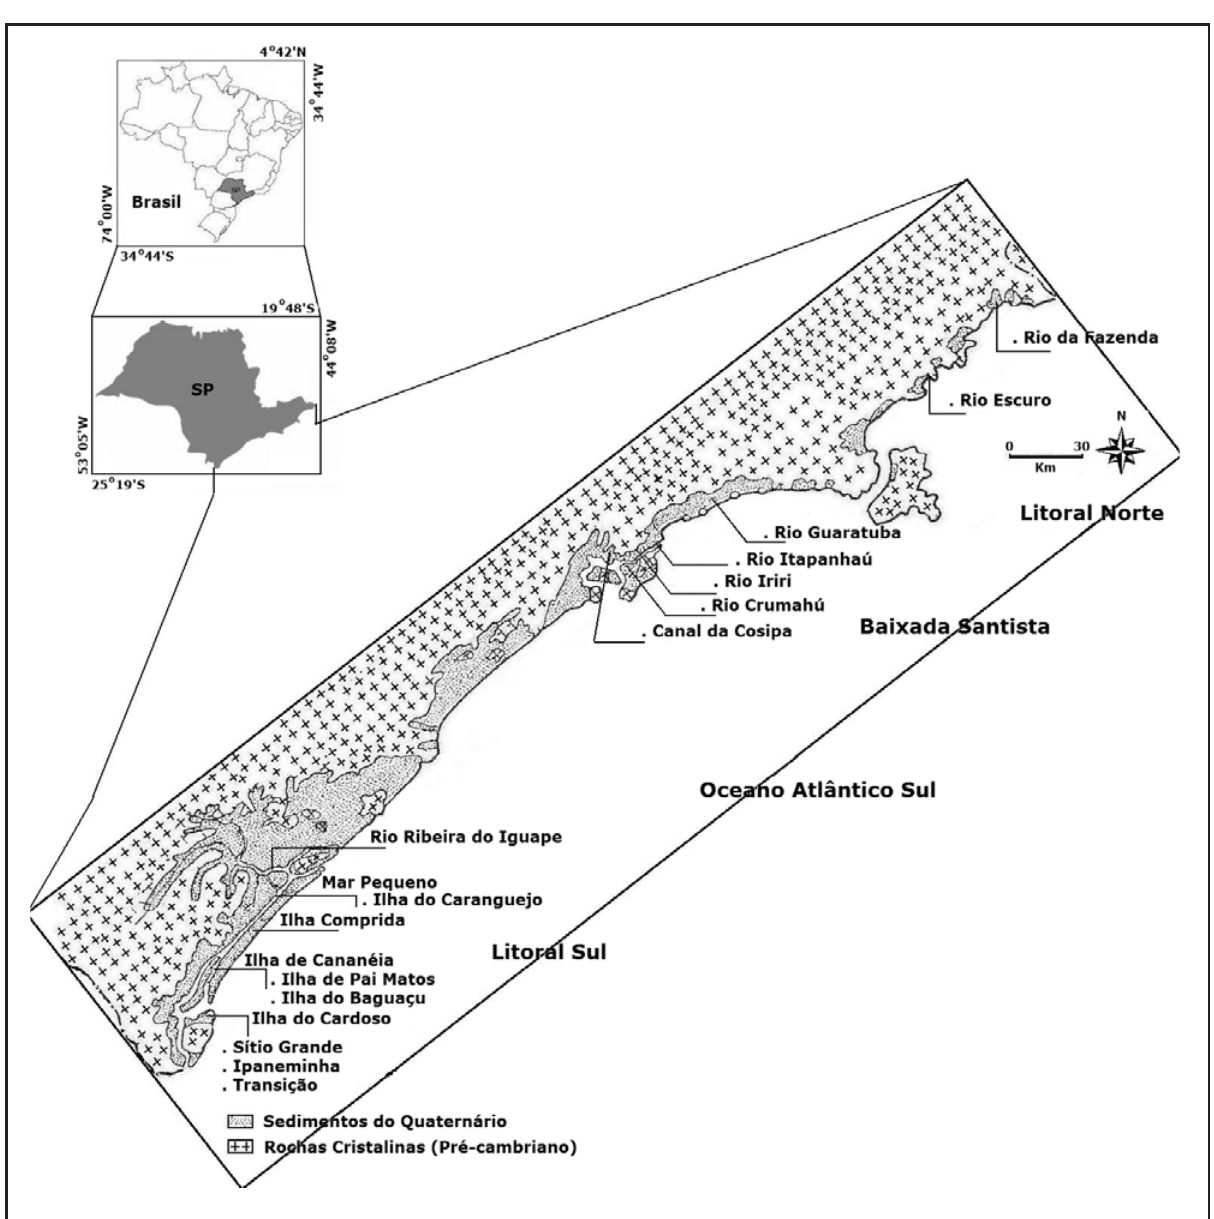
Figura 1. Geologia e compartimentação geomorfológica das planícies costeiras do Estado de São Paulo. Fonte: Modificado de Suguio & Tessler (1992), com a localização dos pontos